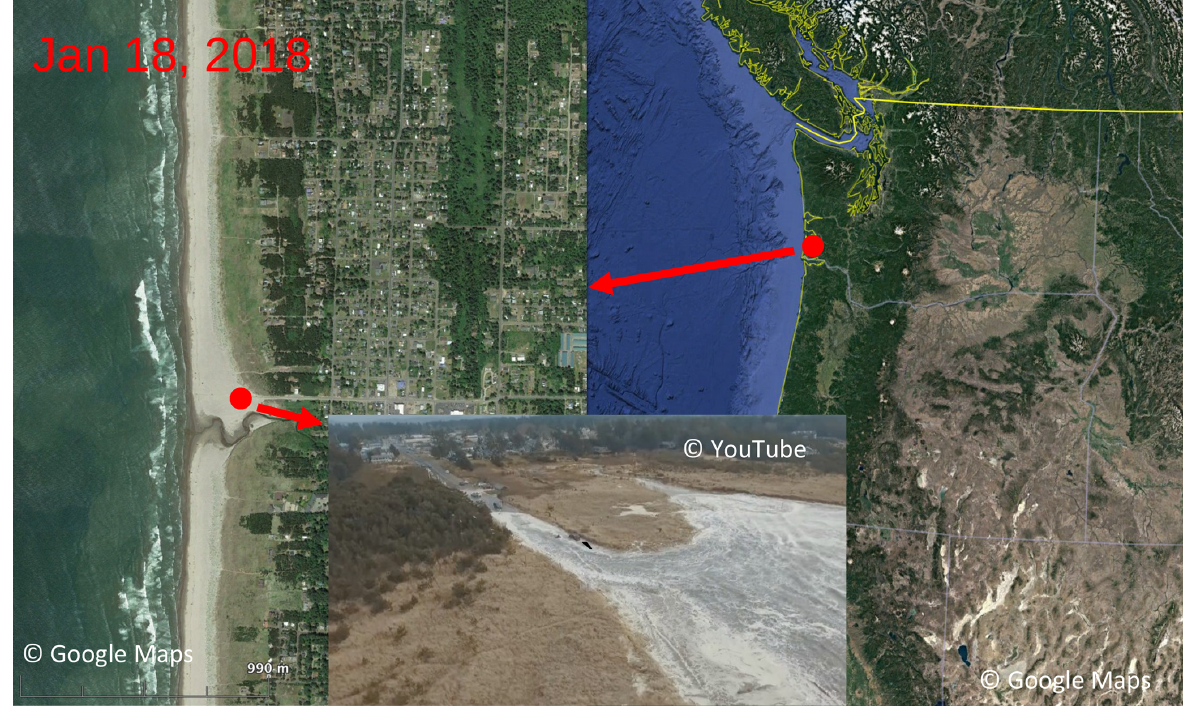
Figure 11. Location and a photograph from an extreme runup event on 18 January 2018 (satellite images from © Google Maps, insert from Wilkins, 2020).